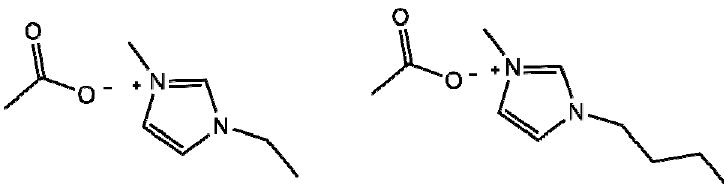
Figure 18. Chemical structure of the acetate salts of 1-ethyl-3-methylimidazolium, Emim, and 1-butyl-3-methylimidazolium, Bmim.